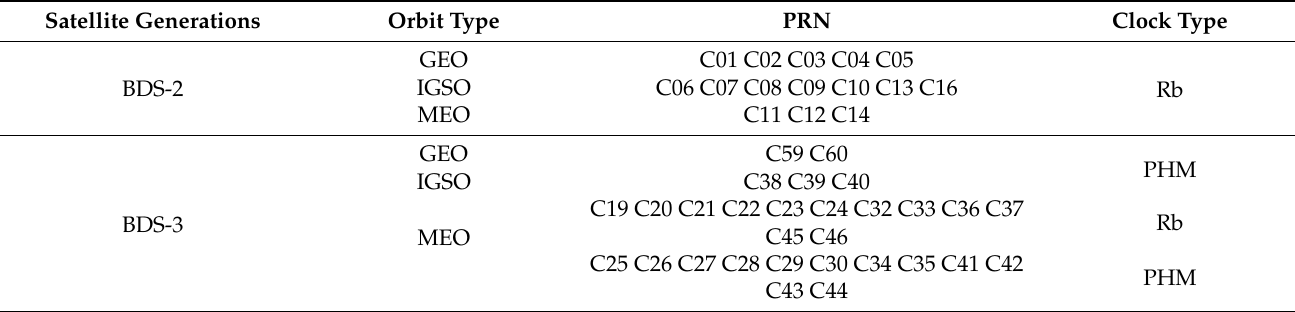
Table 2. Detail information of BDS satellites [28].